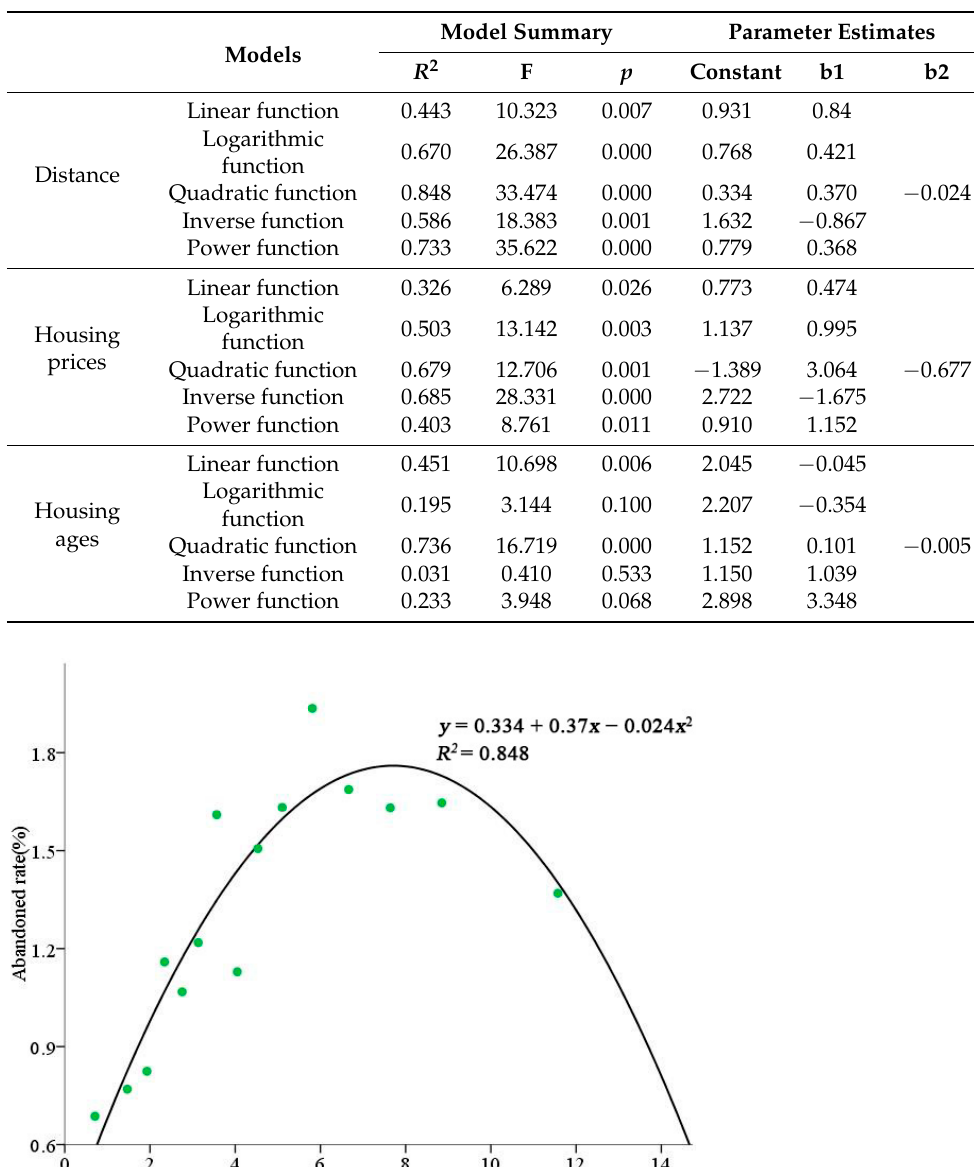
Table 2. Comparison of the relationship between the three influencing factors and the abandonment rate of the residential quarter.